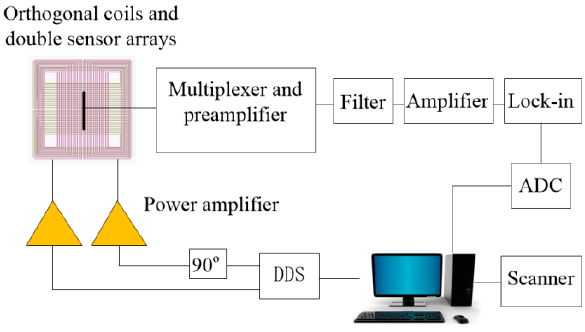
Figure 13. Block diagram of experiment system.